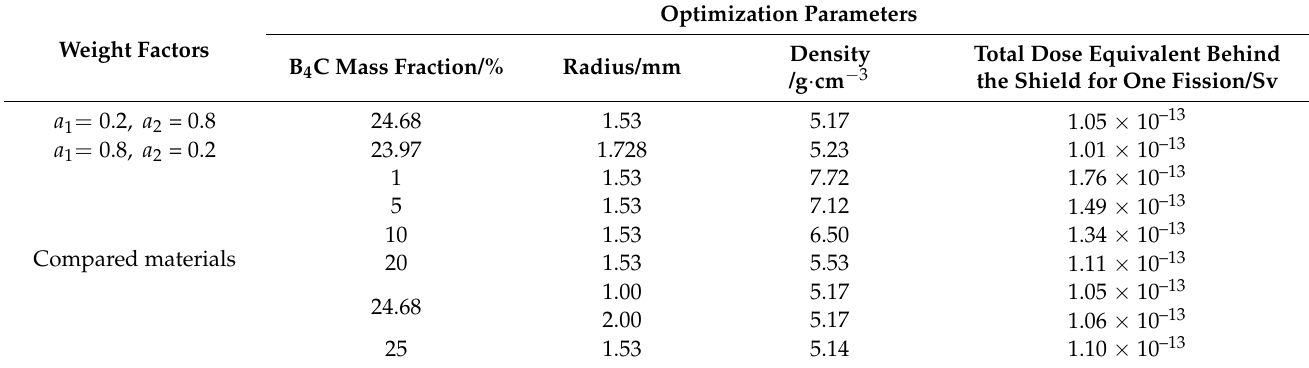
Compared materials